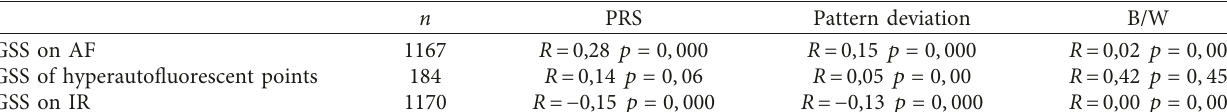
Table 3: Correlations between AF, hyperautofluorescent points, and IR grey scales with CMP PRS, CMP Pattern Deviation, and B/W, respectively.